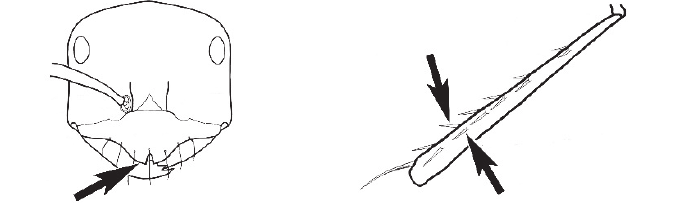
of two rows of preapical spines ( M . aeneovirens complex) .......................... 16